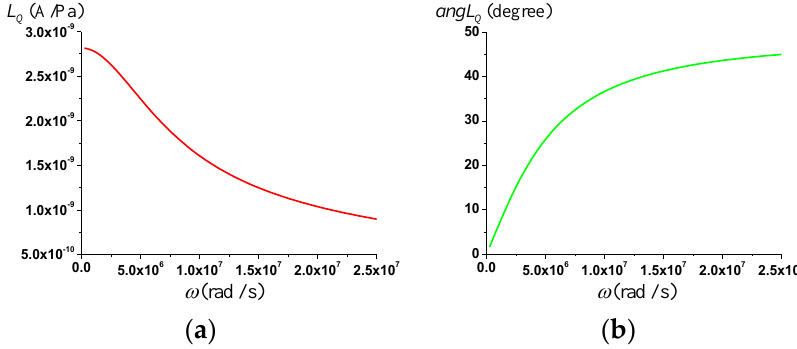
Figure 5. Variation with frequency (time-harmonic case): ( a ) amplitude; ( b ) phase.